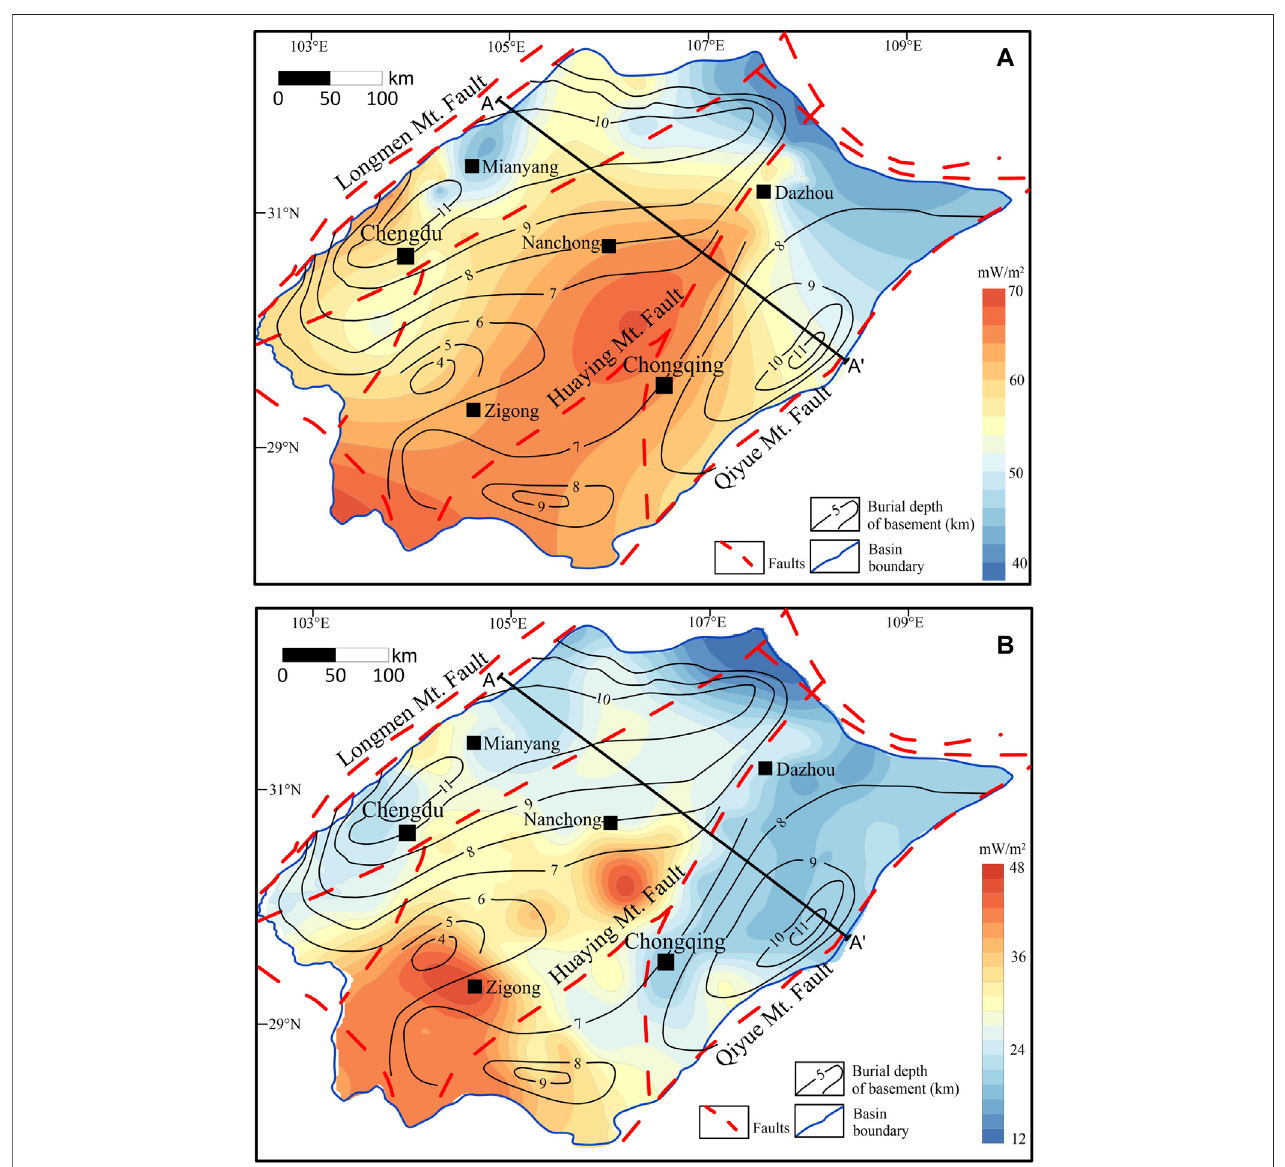
FIGURE3| distribution (A) (editedafterXuetal.,2011;Zhuetal.,2018aandQiuetal.,2022),themantleheat fl owdistribution (B) andtheburialdepthofthefolded basement(editedafterLuo,1998)oftheSichuanBasin.Themantle heat fl owwascalculatedbasedonthesurfaceheat fl ow,theheatproductionrateinthesedimentary layers, the basement and the other parts of the crust. An obvious correlation can be found from both of the surface heat fl ow, mantle heat fl ow and the basement burial depth.